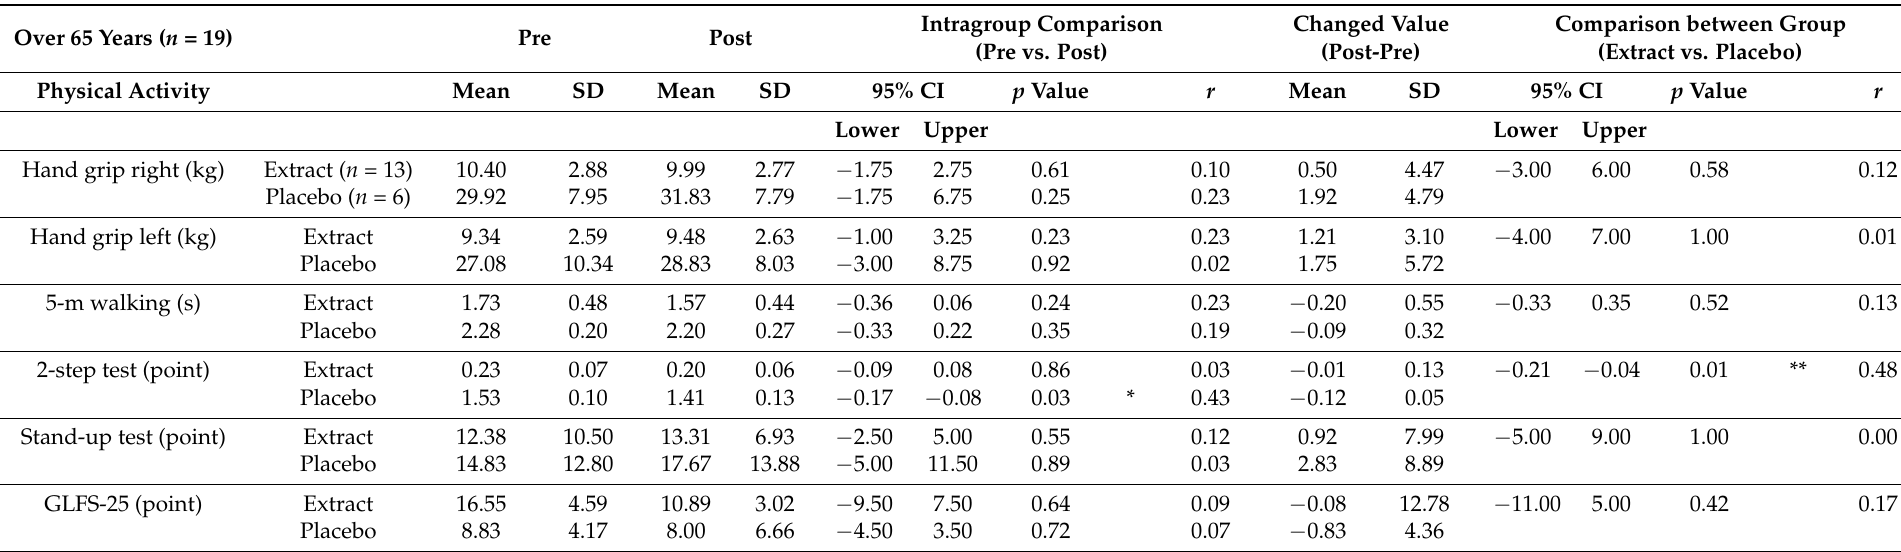
Table 6. Comparison of physical activity scores in subjects aged >65